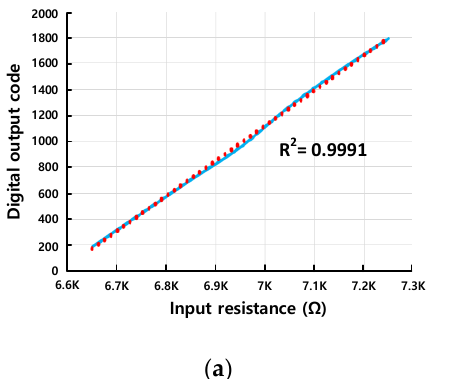
Figure 10. Measured input referred noise in the voltage-sensing mode.